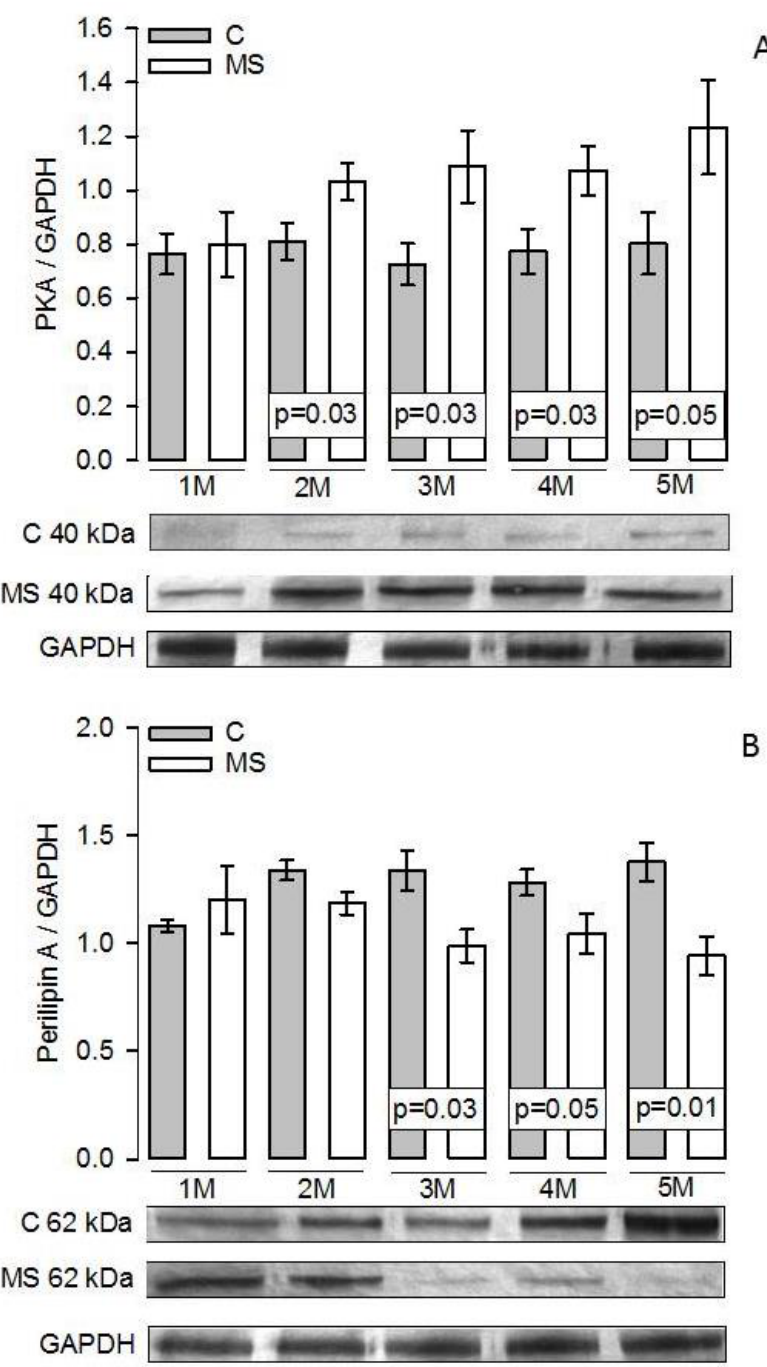
Figure 4. Representative histograms of the PKA / GAPDH expression ( A ) and Perilipin A / GAPDH expression ( B ). Values are the mean ± SEM n = 7 rats per experimental group. Abbreviations: C = Control; MS = Metabolic syndrome; PKA = Protein kinase A; GAPDH = Glyceraldehyde-3-phosphate dehydrogenase; M = Month.